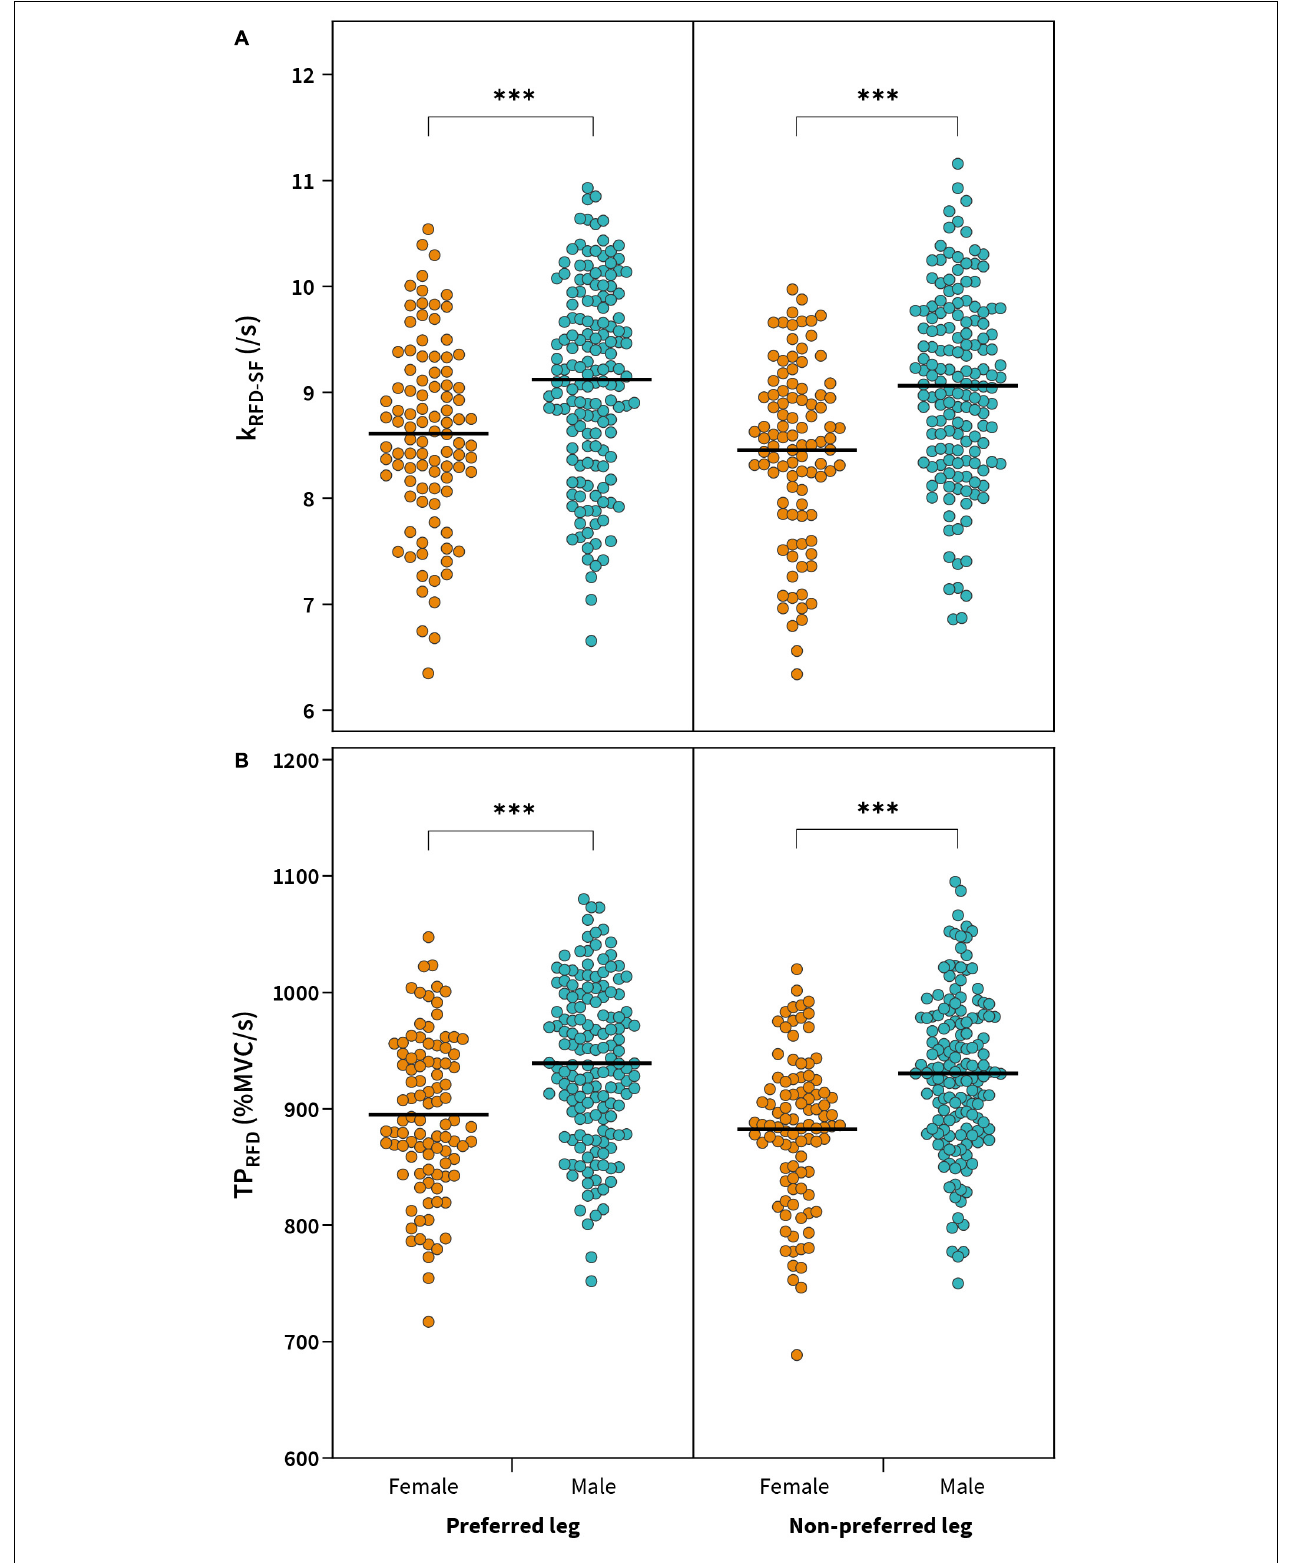
FIGURE 3 | Comparison between females and males for RFD-SF slope (k RTD − SF ) (A) and theoretical peak rate of force development (TP RFD ) (B) . ∗∗∗ p < 0.001.